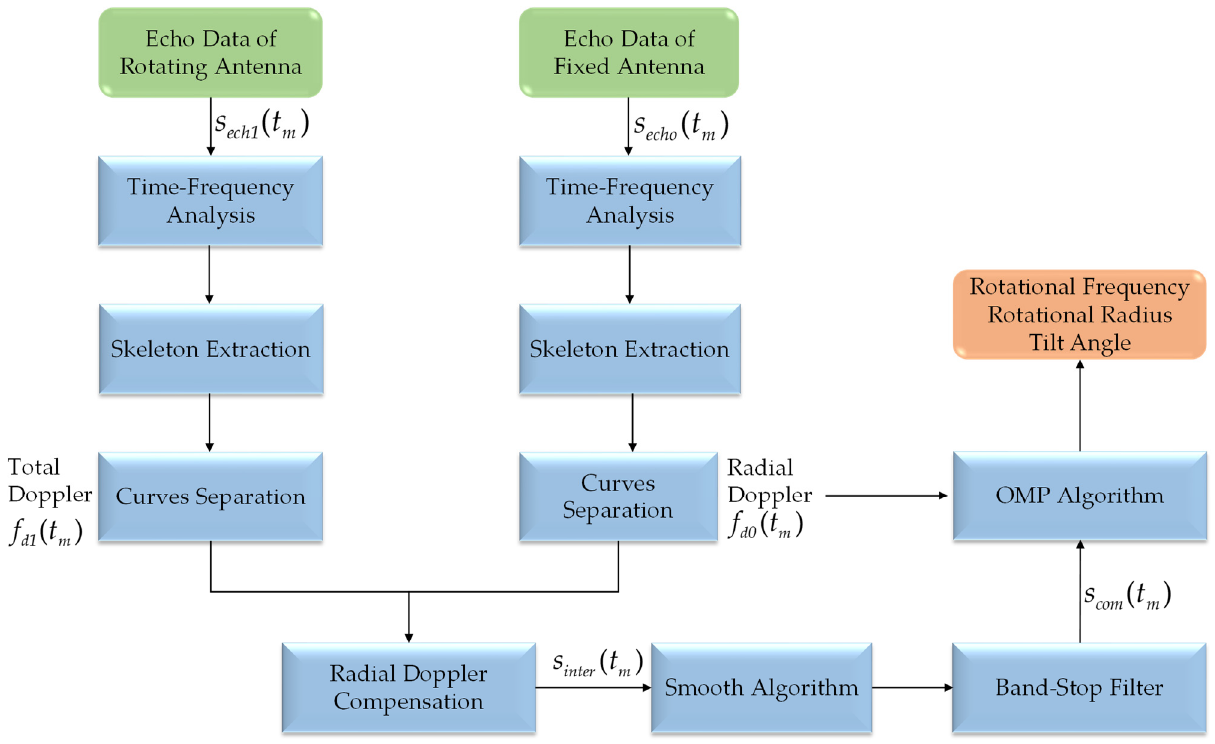
Figure 3. The flow chart of the proposed method.